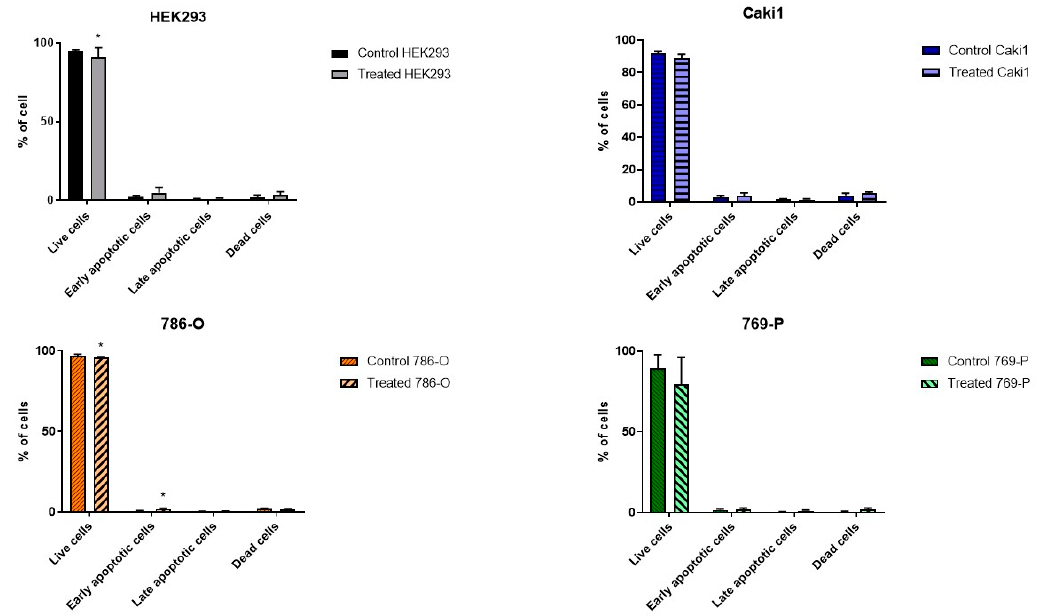
Figure 2. Results of the cytometric analysis of cell apoptosis under the influence of 4.5 mT, 50 Hz ELF-EMF. Data presented as mean ± standard deviation: *— p <